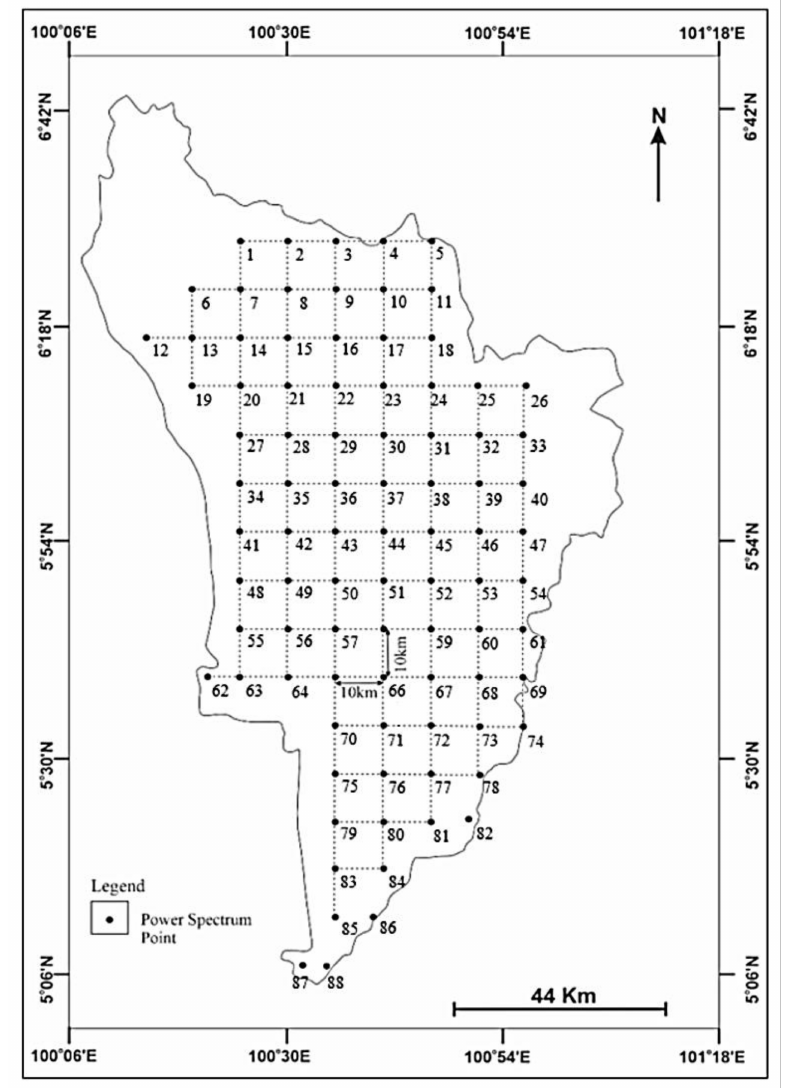
Figure 10. Power spectrum location map.